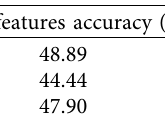
Table 2: Accuracy of emotion recognition on HEIV dataset.